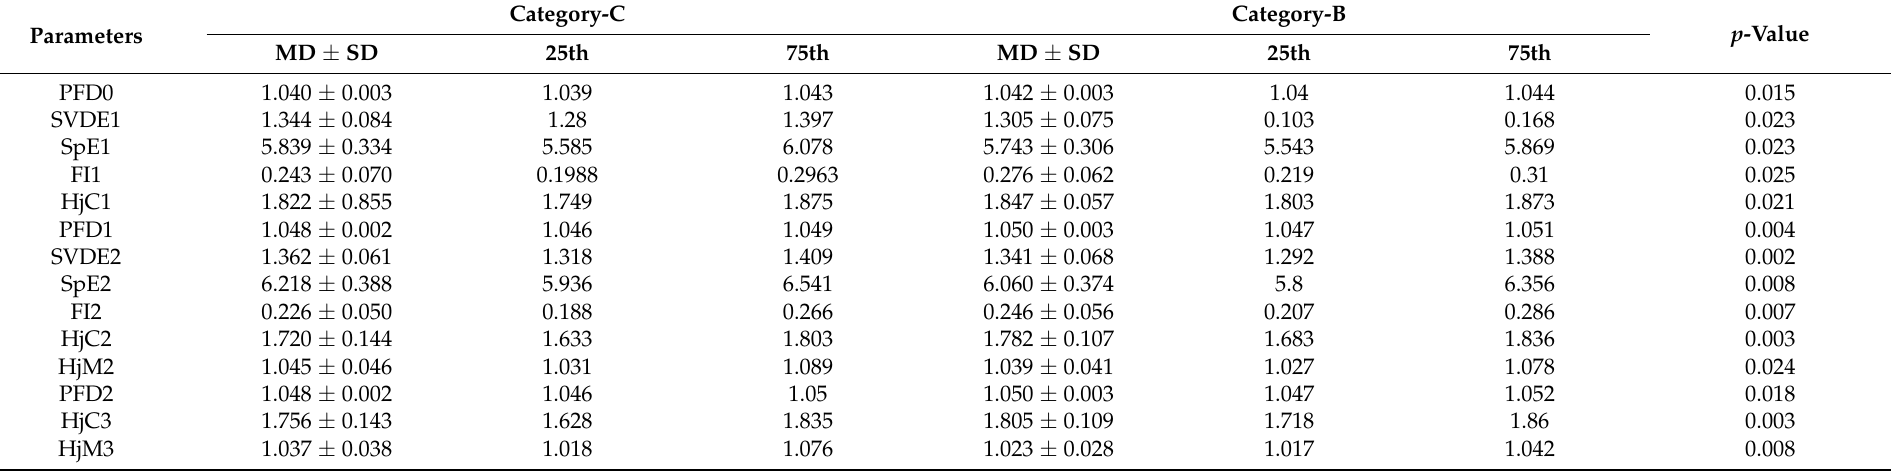
Table 5. Characteristics of statistically important parameters extracted from db02 mother wavelet-based level 2 decomposition of the HRV signals using WPD.